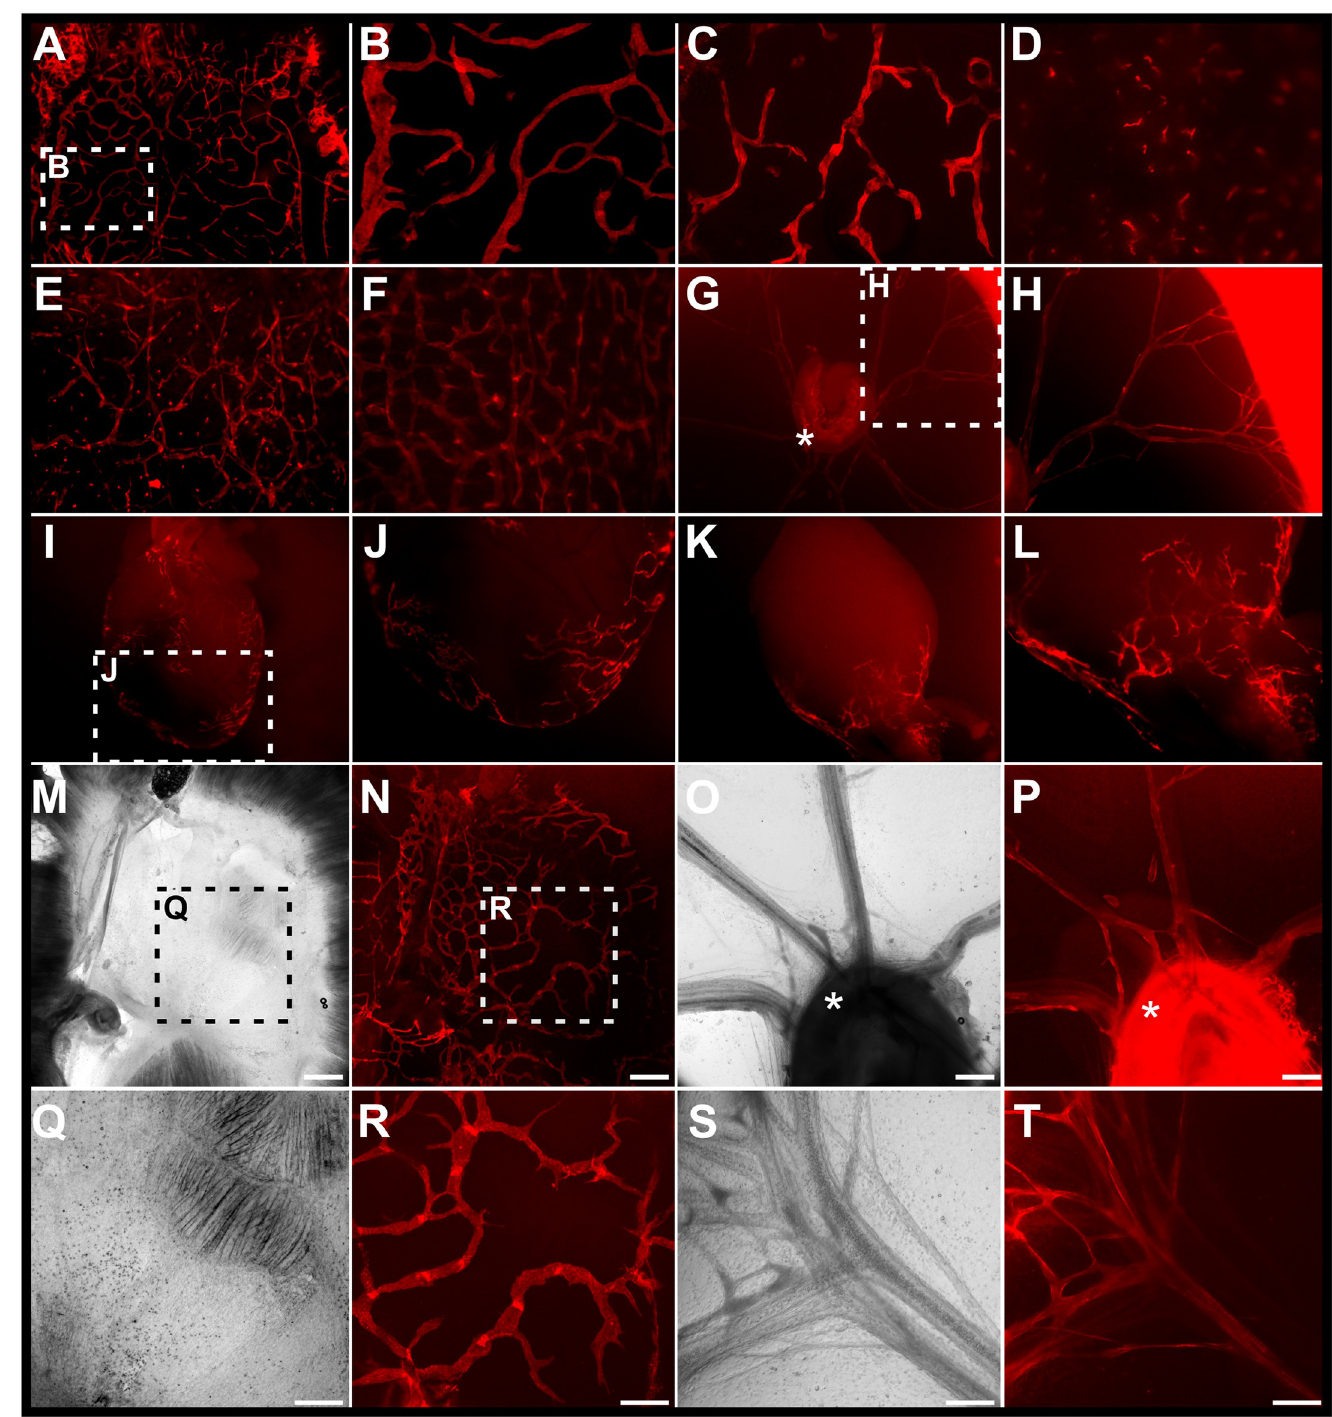
Fig 2. Characterization of the reporter expression in Vegfr3 -tdTomato transgenic mice. Tissues prepared from adult mice (A-F, I-J) and pups at postnatal day 5 (G-H, K-T) were analysed for lymphatic expression of the Vegfr3 -tdTomato transgene in a fluorescence stereo dissection microscope (A-L) and an inverted fluorescence microscope (M-T). Distinct lymphatic networks were detected in various adult tissues including the diaphragm (A-C), lung (D), ear dermis (E), intestinal mucosa (F), and heart (I-J) as well as postnatal tissues including the mesentery (G-H, O-P, S-T), mesenteric lymph nodes (G, O-P), heart (K-L) and diaphragm (M-N, Q-R). White asterisk denotes the position of the LN. The white and black boxed areas are magnified in the indicated panels. Scale bars = 400 μ m (M-P) and 200 μ m (Q-T).